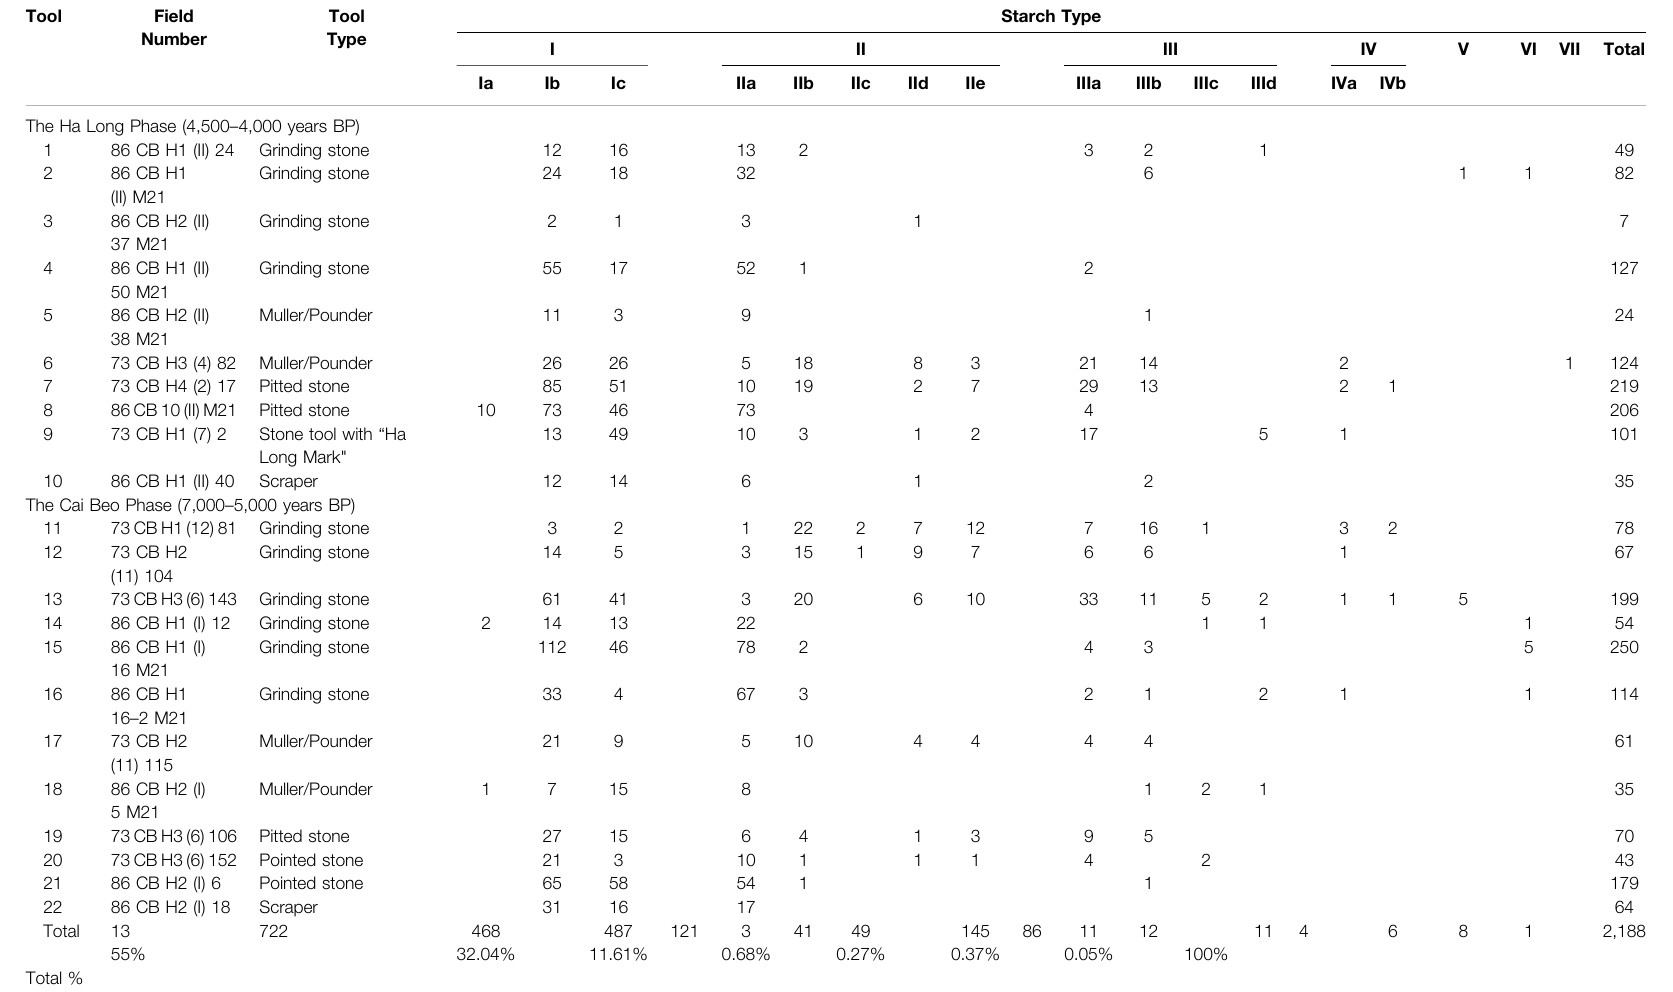
TABLE 1 | Types and numbers of starches recovered from the study of stone tools from the Cai Beo site.